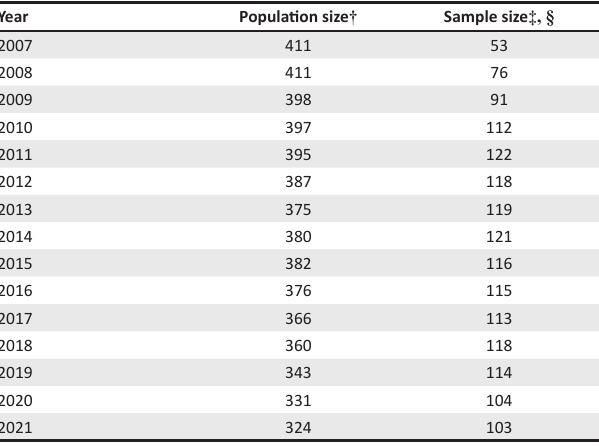
TABLE 1: Population and sample sizes per